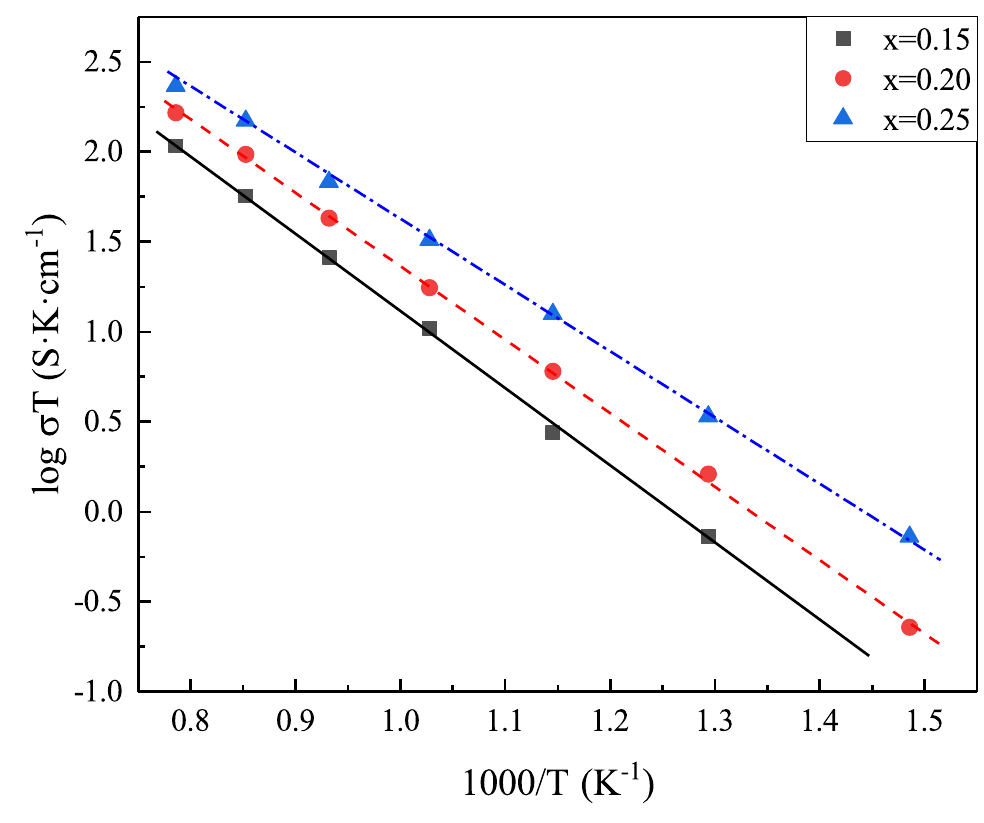
Figure 4. Arrhenius plots for total conductivities with four-probe DC methods.